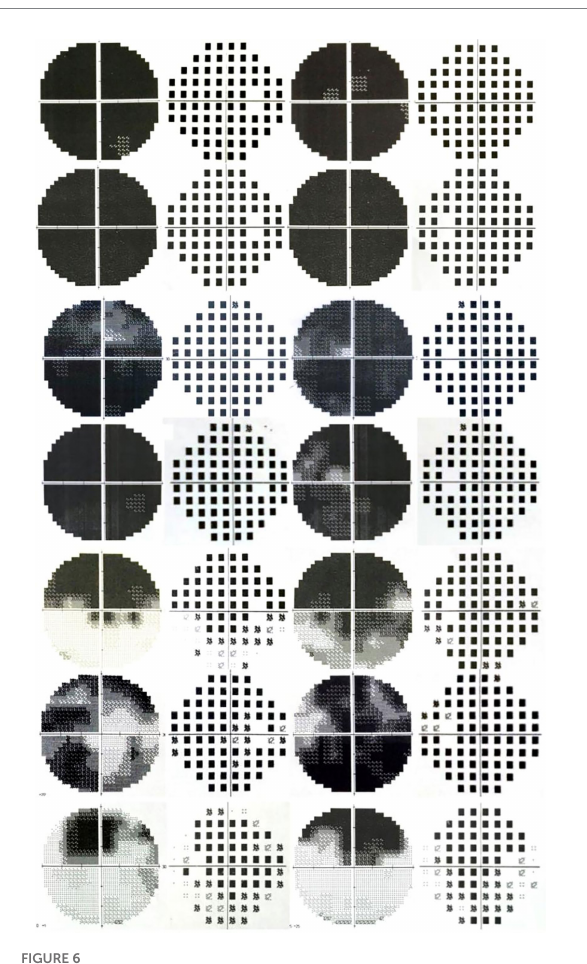
FIGURE 6 VF examination results during the acute phase of the